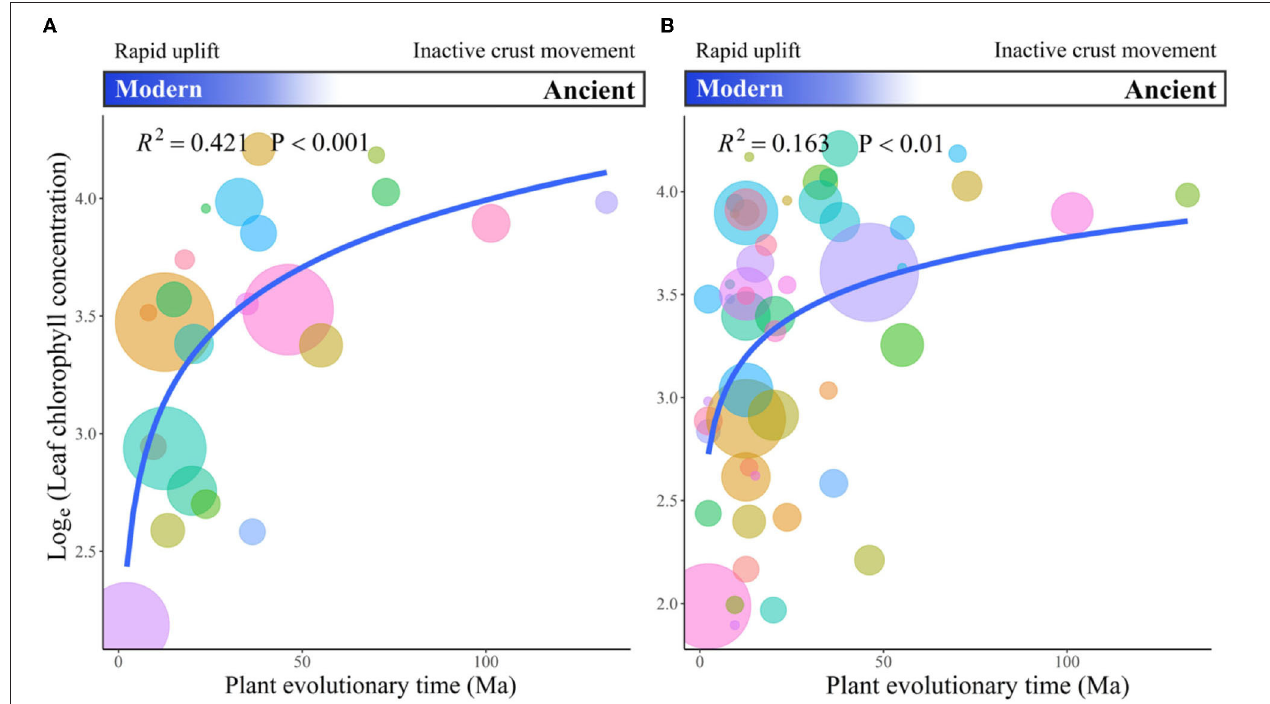
FIGURE 4 | The relationships between leaf chlorophyll (Chl) and plant evolutionary time (million years) at both family (A) and genus levels (B) . Different colors represent different plant families or genera. The size of dots represents the number of site species at family or genus levels. The blue lines represent the regression